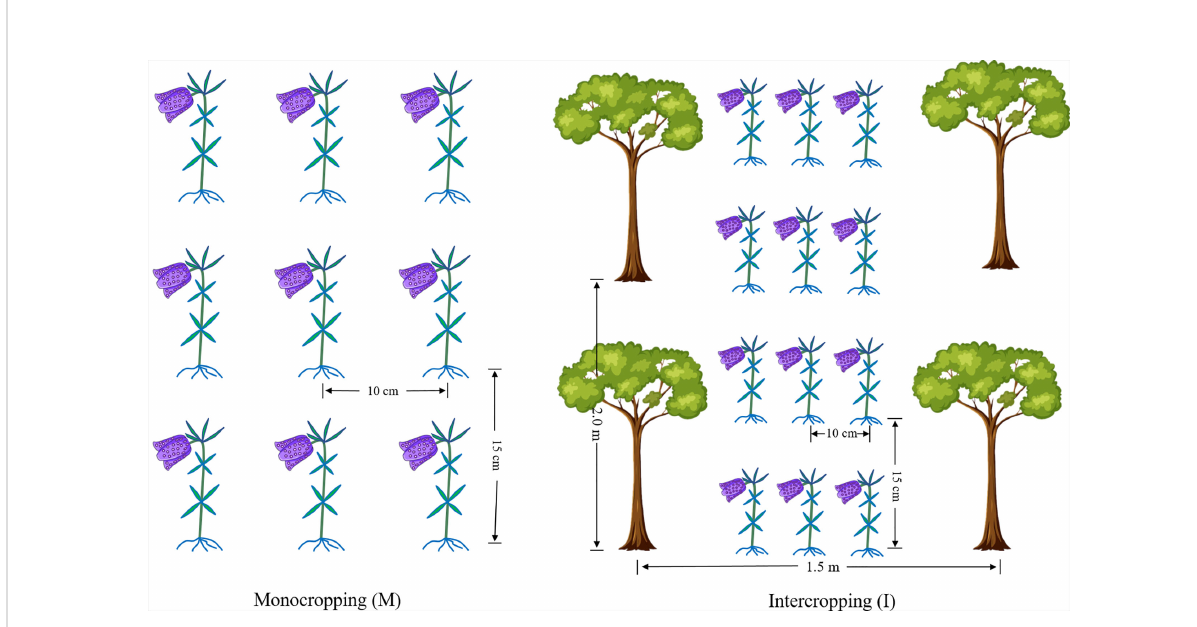
FIGURE 1 The cropping patterns of F. hupehensis monocropping and F. hupehensis-M. of fi cinalis